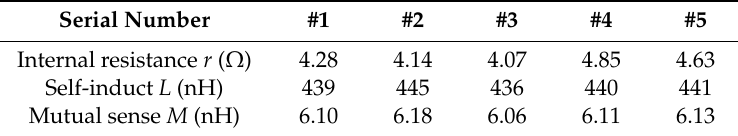
Table 2. Impedance parameters of the PCB Rogowski coil.